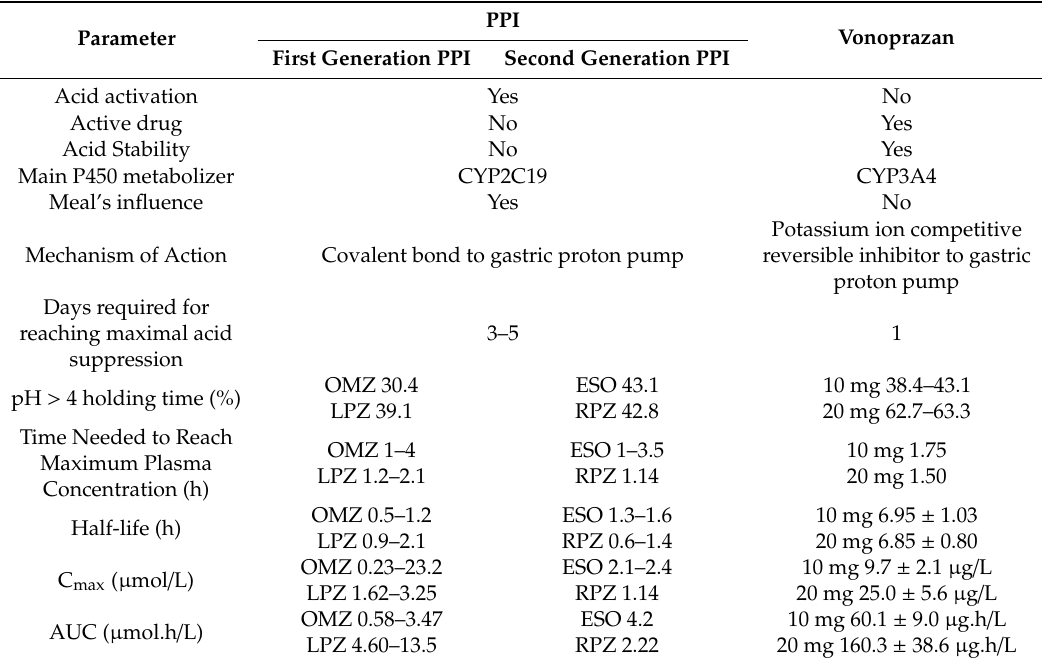
Table 2. Pharmacological comparisons between PPI and